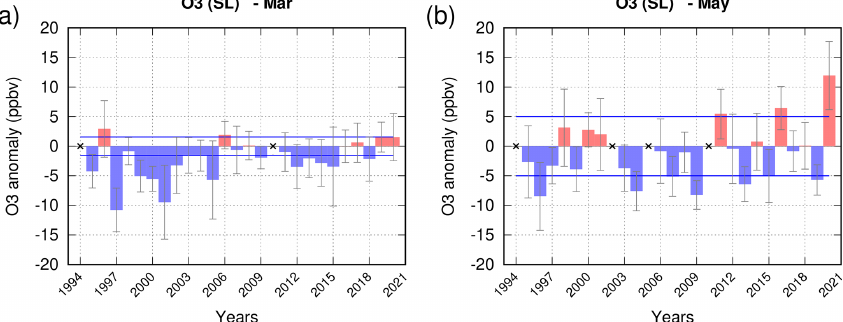
Figure 2. Anomalies of ozone for 1994–2020 calculated with respect to 2016–2019 for the months of (a) March and (b) May for the surface layer ( > 950hPa; SL). There were no ozone data in April 2020. The grey bars represent the 95% confidence limits, and the blue horizonal lines represent the interannual variability.